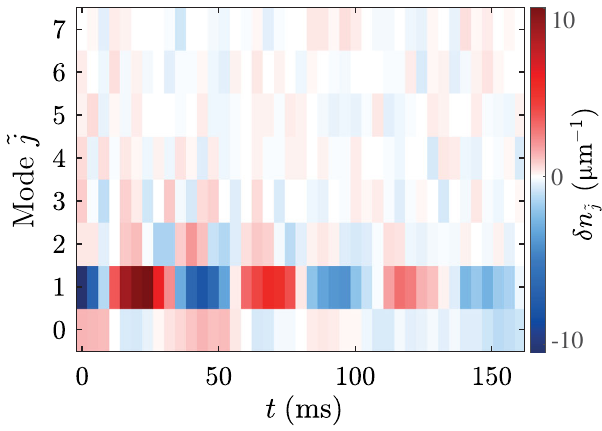
FIG. 9. Fourier spectrum of the measured density perturbation of coldest quench illustrated in Fig. 2. In the GHD simulations, the odd modes vanish, justifying the expansion of the perturba- tion as a sum of even